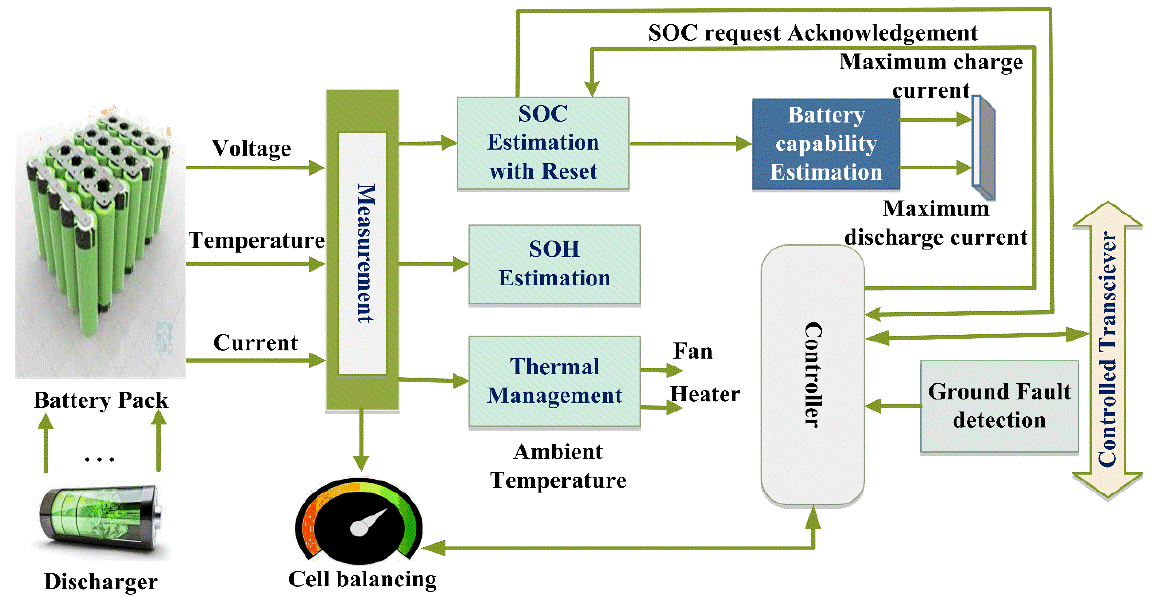
Figure 4. Block diagram of the BMS.